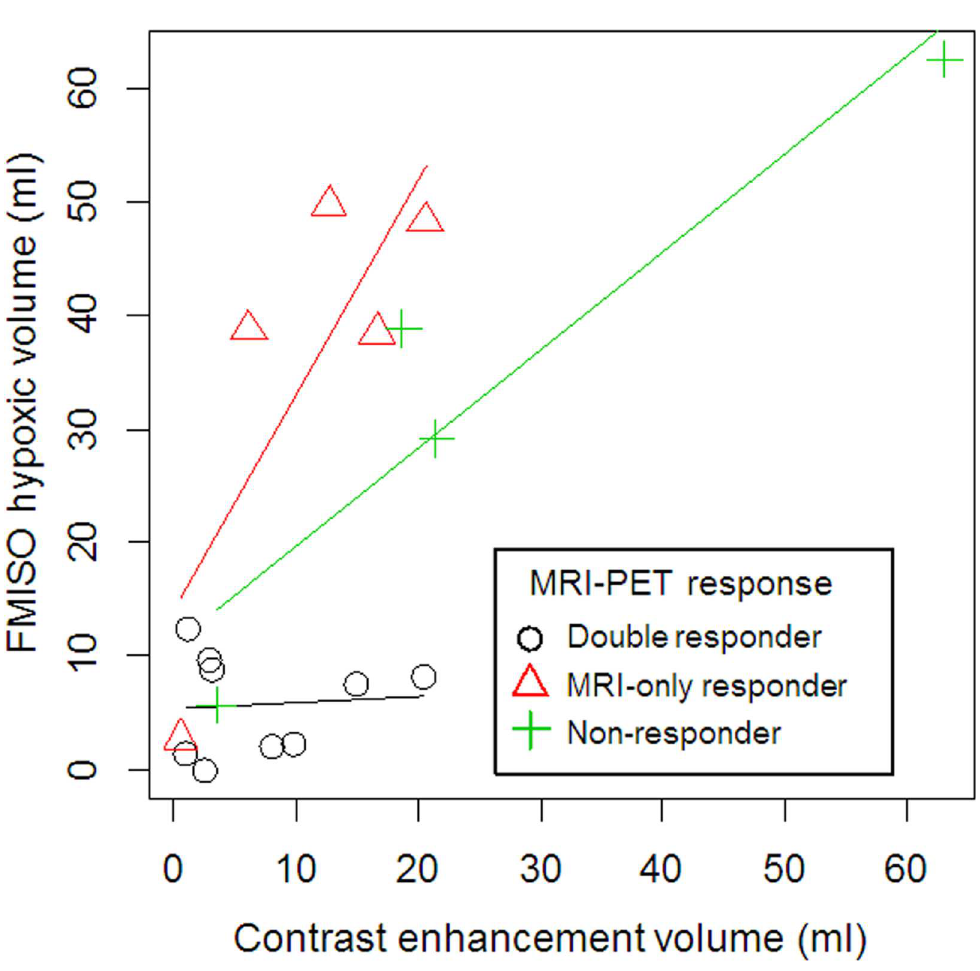
Fig 3. Correlation between contrast-enhanced tumor volumes and FMISO hypoxic volumes 3 to 4 courses after BEV treatment according to treatment response groups. Circles, Triangles, and Crosses represent MRI-FMISO doubleresponders, MRI-only responders, and non-responders, respectively.